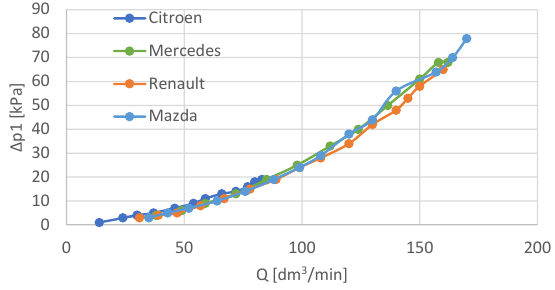
Fig. 9. Characteristics of individual CP pumps without damping – pressure as a function of volumetric flow rate